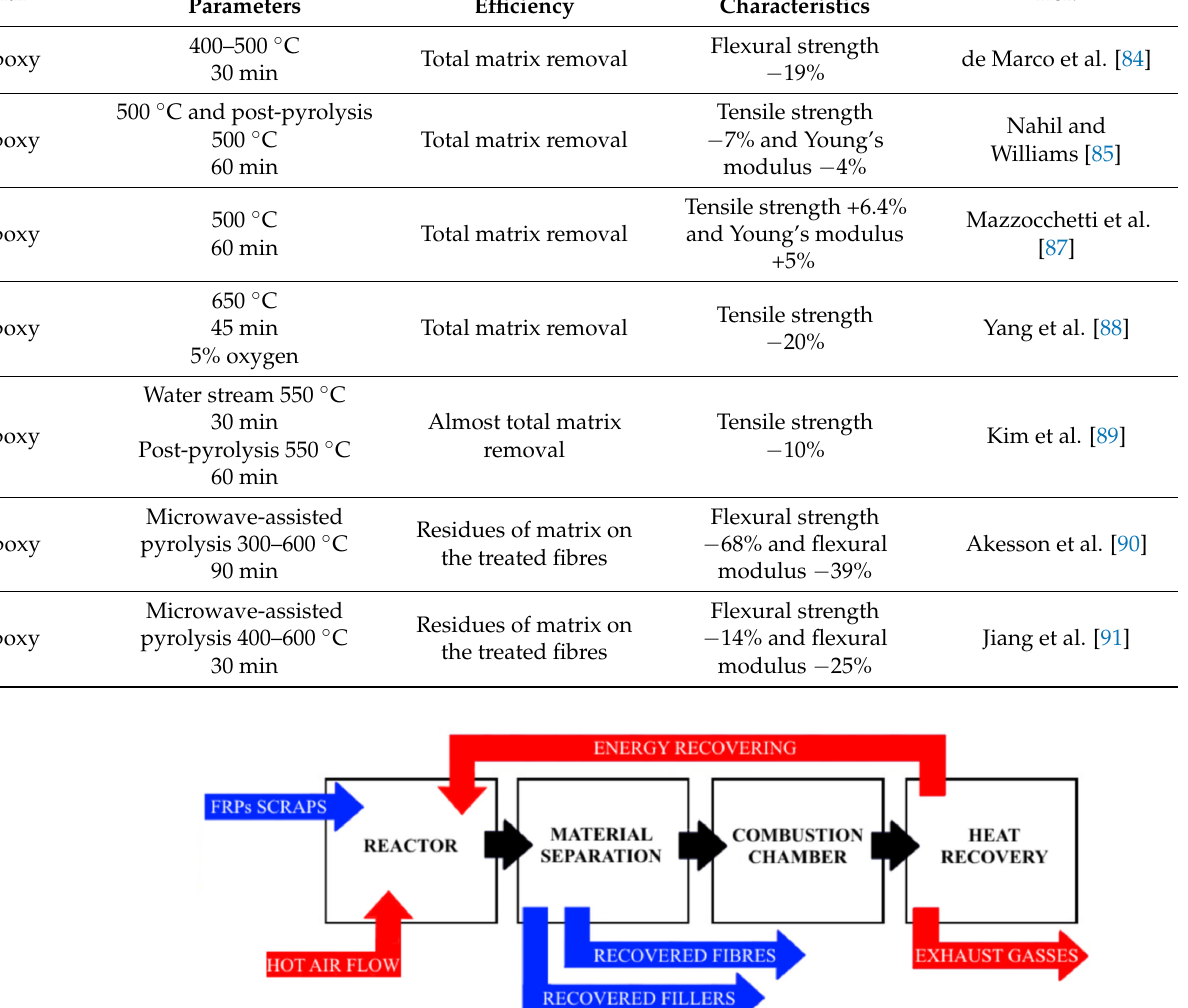
Figure 10. Schematisation of a ge neric fluidised bed recycling process.